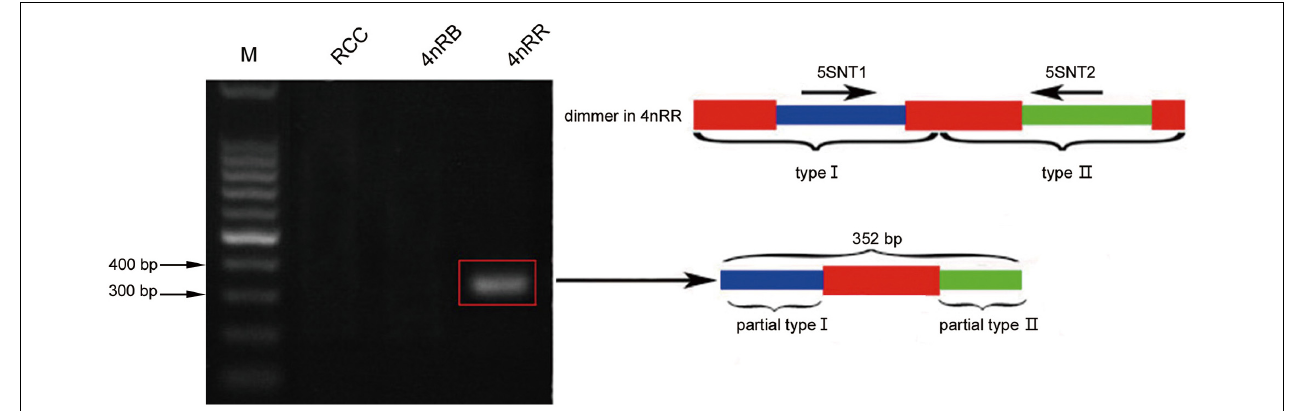
FIGURE 5 | DNA bands amplified from 4 n RR. Using the primer pair 5S NT1- 5S NT2R, DNA fragments were only amplified from 4 n RR (approximately 352 bp); M, DNA ladder markers (100 bp increments); red indicates the 5S rRNA gene, blue indicates NTS of type I, and green indicates NTS of type